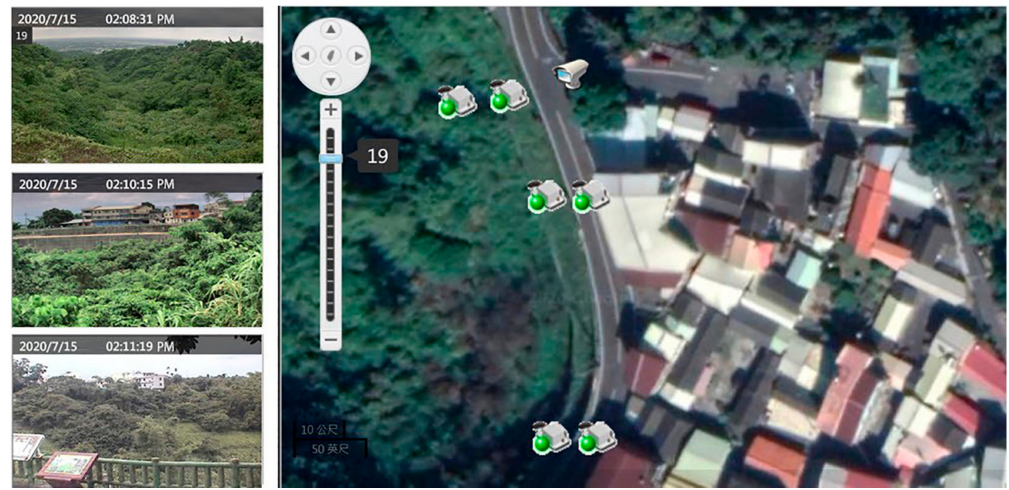
Figure 6. Real-time image displays of the status of the study site (green dots are normal